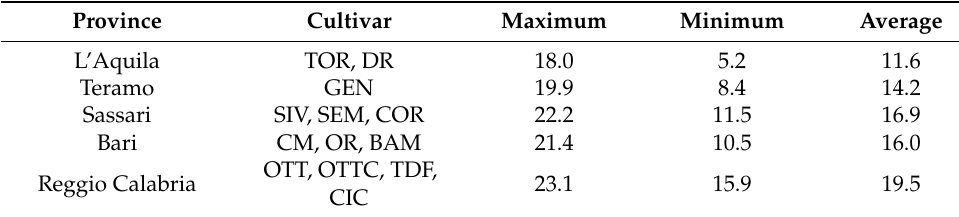
Table 1. Temperatures ( ◦ C) recorded in 2017 in the selected Italian provinces 1 . Province